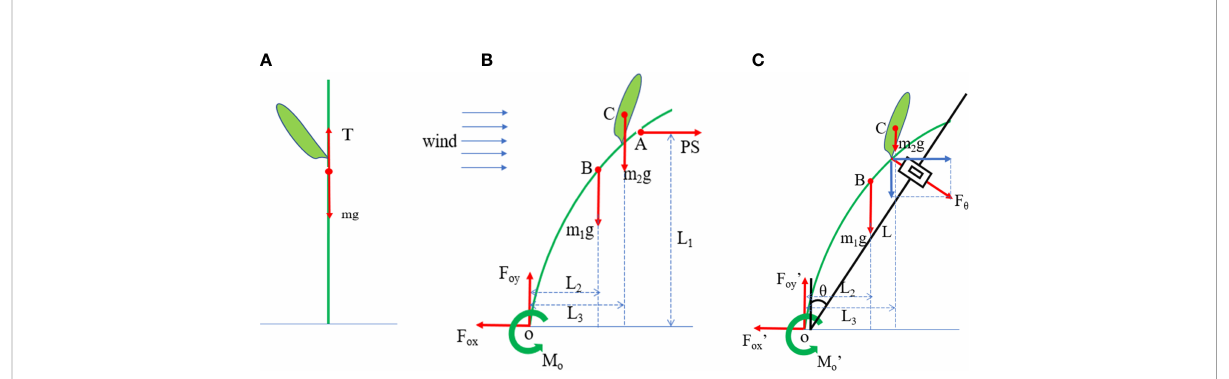
FIGURE 3 Analysis of maize plant force. (A) Stress analysis of maize plants under windless conditions. T , ground support force; mg , gravity of maize plant. (B) Stress analysis of maize plants under the in fl uence of external wind. (A) , the concentrated stress point on the windward side of a maize plant; B, the center of gravity of stalk part of maize plant; (C) , the center of gravity of ear part of maize plant. PS , wind force exerted on maize plant; m 1 g , gravity of stalk part of maize plant; m 2 g, gravity of ear part of maize plant; F ox , horizontal force on maize root; F oy , vertical force on maize root; L 1 , arm of force of PS ; L 2 , arm of force of m 1 g ; L , arm of force of m 2 g ; O , stem base; M o , resistance moment of maize plant. (C) Pulling force given to the maize plant by the apparatus during the resistance to overturning test. q , inclination angle of vertical shaft of instrument, F q , tension at inclination angle q ; L, the arm of F q , F ox ′ , horizontal force on maize root, F oy ′ , vertical force on maize root; M o ′ , resistance moment of maize